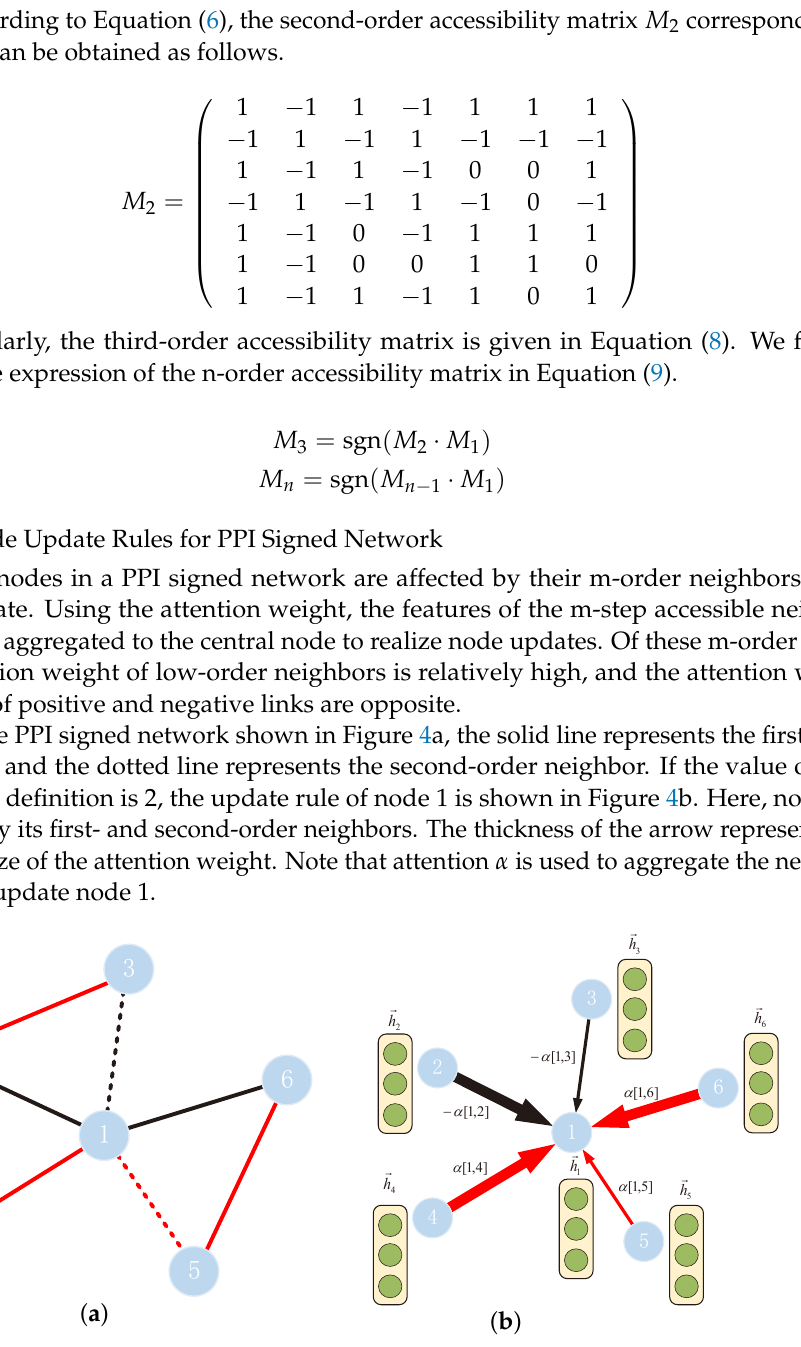
Figure 4. ( a ) PPI signed network, where the solid line represents the first-order neighbor and the dotted line represents the second-order neighbor. ( b ) Update rules for node 1, where the thickness of the arrow represents the relative size of the attention